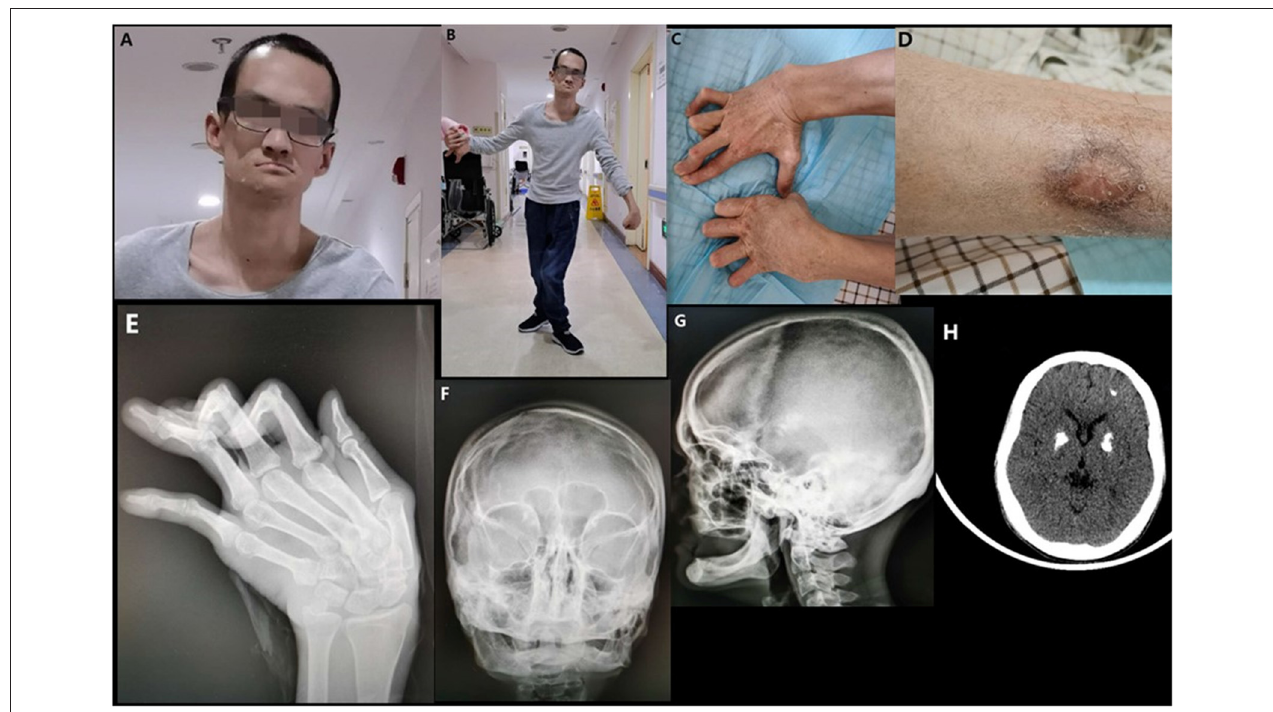
FIGURE 1 | Clinical images of the proband. (A) The facial characteristics of the proband (broad forehead, high anterior hairline, and a thin upper vermilion). (B) Spastic gait and dystonia of wrists. (C) Contracture of the fingers. (D) Scarring and pigmentation following ulceration of the leg. (E) Deformities of the interphalangeal joints and ulnar deviation of the left metacarpal. (F) Deformity of both maxilla and mandible. (G) Complete loss of teeth and alveolar bone. (H) Multiple intracranial calcifications (bilateral lenticular and frontal lobe).